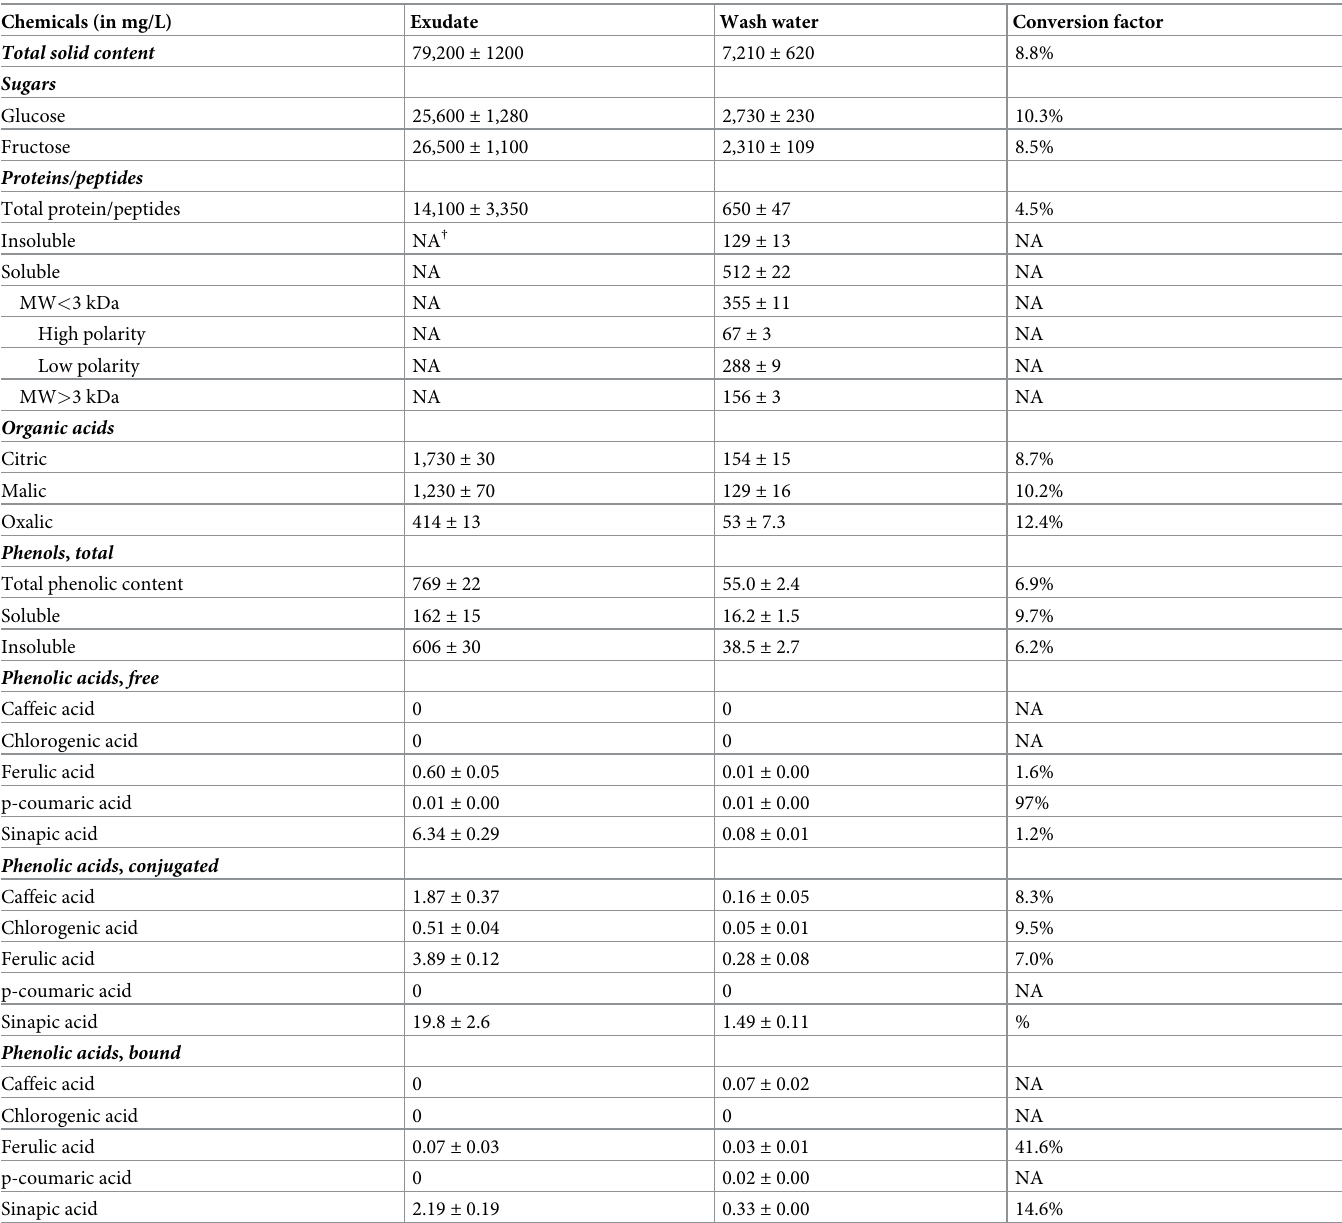
Table 2. Chemical composition of cabbage exudate and wash